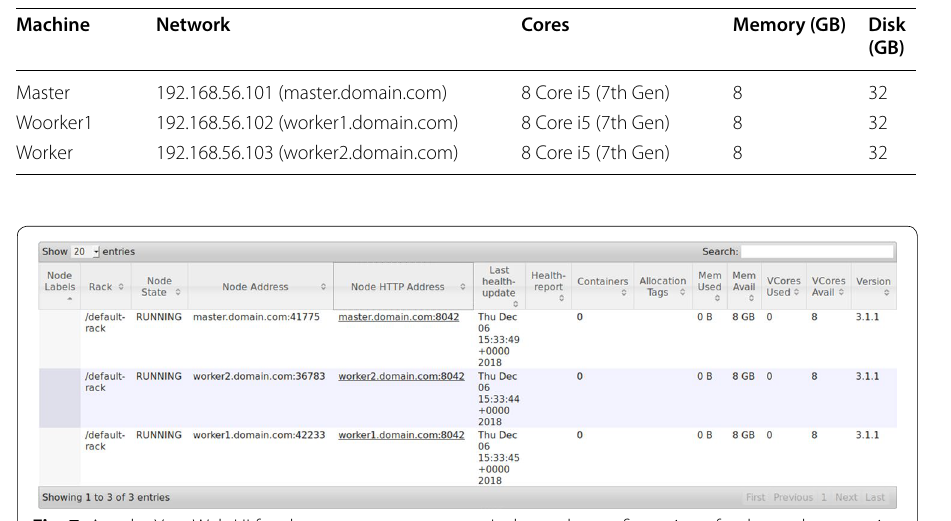
Fig. 7 Apache Yarn Web UI for cluster resource manager: It shows the configuration of a cluster that contains three nodes. One node defined as a master and the rest are the